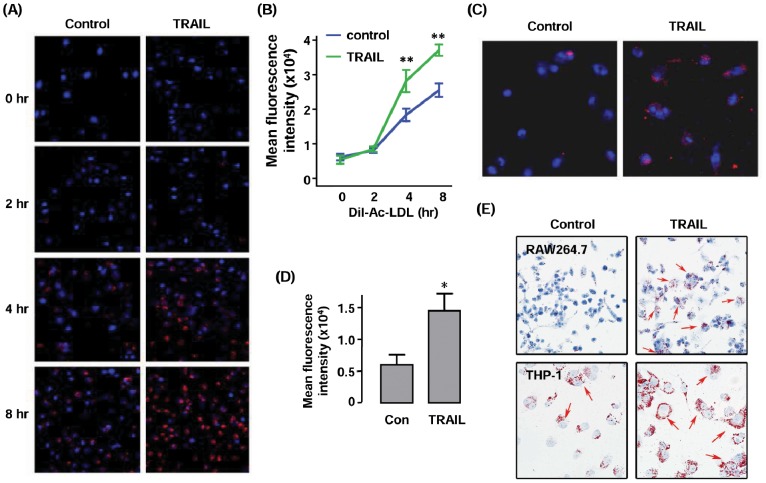
Effects of TRAIL on lipid uptake and foam cell formation in macrophages.(A) Fluorescence images showing the effects of TRAIL on DiI-Ac-LDL (red) uptake in RAW264.7 cells. Cells were pretreated with TRAIL (10 ng ml−1) for 24 hr, then loaded with DiI-Ac-LDL for different time as indicated. (B) Quantitative data of the fluorescence intensity in (A). (C & D) Effects of TRAIL (10 ng ml−1 for 24 hr) on DiI-Ac-LDL uptake in PMA-differentiated human THP-1 cells. (E) Effects of TRAIL on ox-LDL-triggered foam cell formation in RAW264.7 and THP-1 cells as detected by Oil Red O staining (red color, arrows). * P<0.05 and ** P<0.01 vs control, unpaired t-test or one-way ANOVA followed by Newman-Keuls test, n = 3.